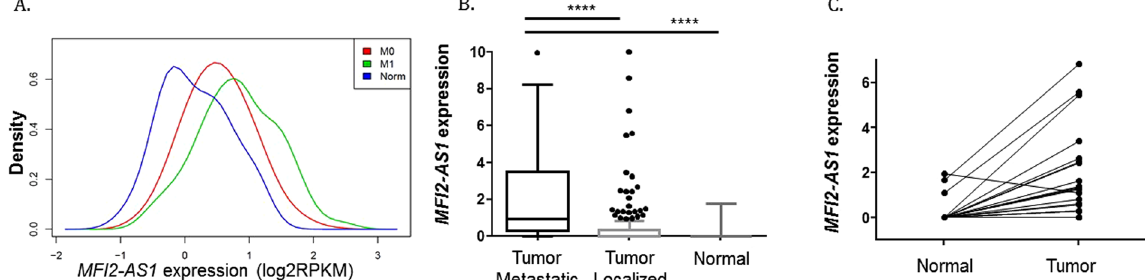
Figure 4. Comparison of MFI2-AS1 expression in normal tissue, localized tumors, and primary tumors from metastatic patients. ( A ) Development cohort. M0: localized tumors, M1: primary tumors from metastatic patients, Norm: normal tissue. ( B ) Validation cohort. ( C ) Expression of MFI2-AS1 in the validation cohort between localized ccRCCs and matched normal